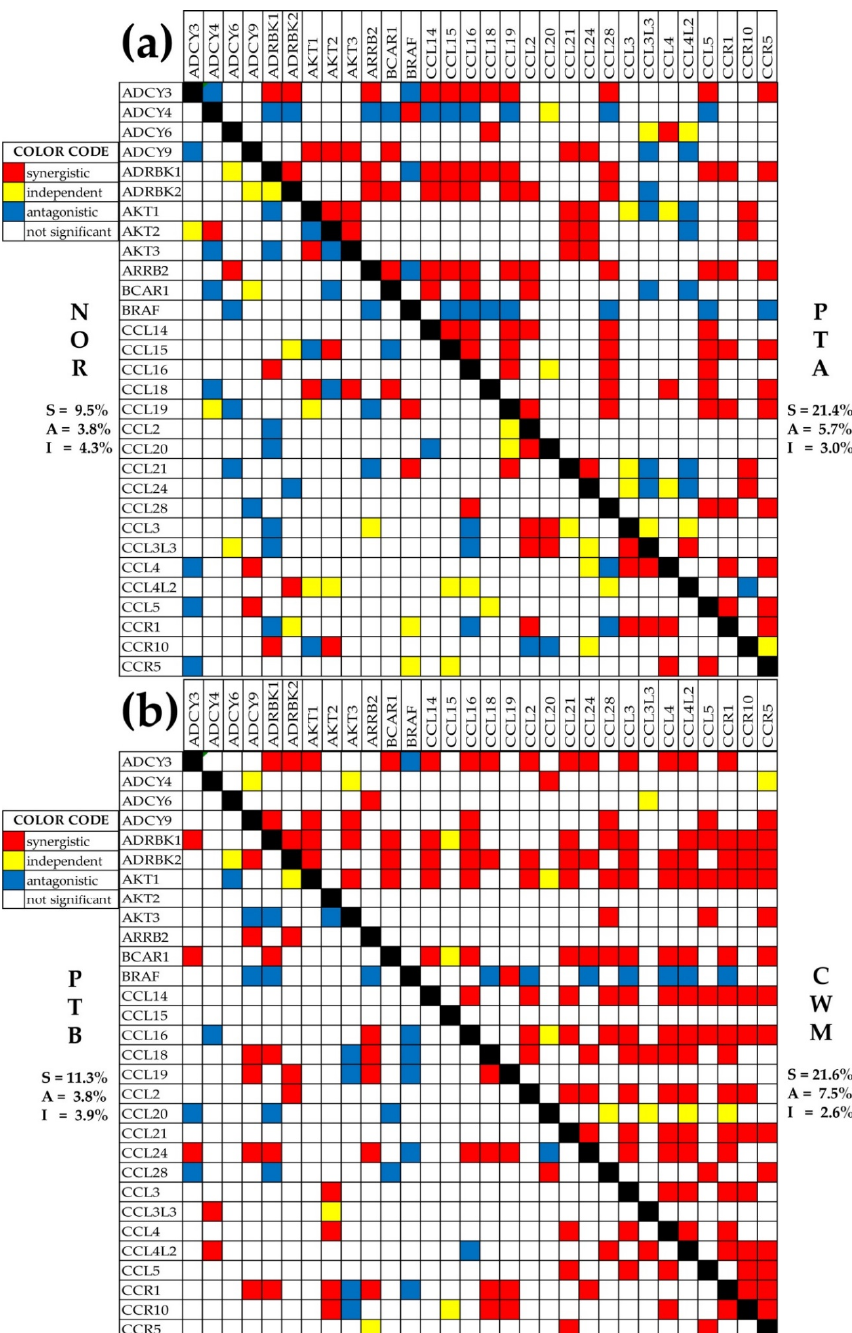
Figure 5. Metastatic ccRCC changed the expression coordination among the chemokine signaling genes. ( a ) Expression correlations in NOR and PTA; ( b ) Expression correlations in PTB and CWM.; The diagonal (black squares) separates the correlation coe ffi cients in the two indicated regions, owing to the symmetry of the Pearson coe ffi cient to the gene permutation. Red / blue / yellow color of a square indicates that the genes labeling the intersecting row and column are significantly synergistically / antagonistically / independently expressed, respectively, while a blank square means that the correlation was not statistically significant. Numbers show the percentage of each type of coordination (S = synergism, A = antagonism, I = independent) for the entire set of 130 chemokine signaling